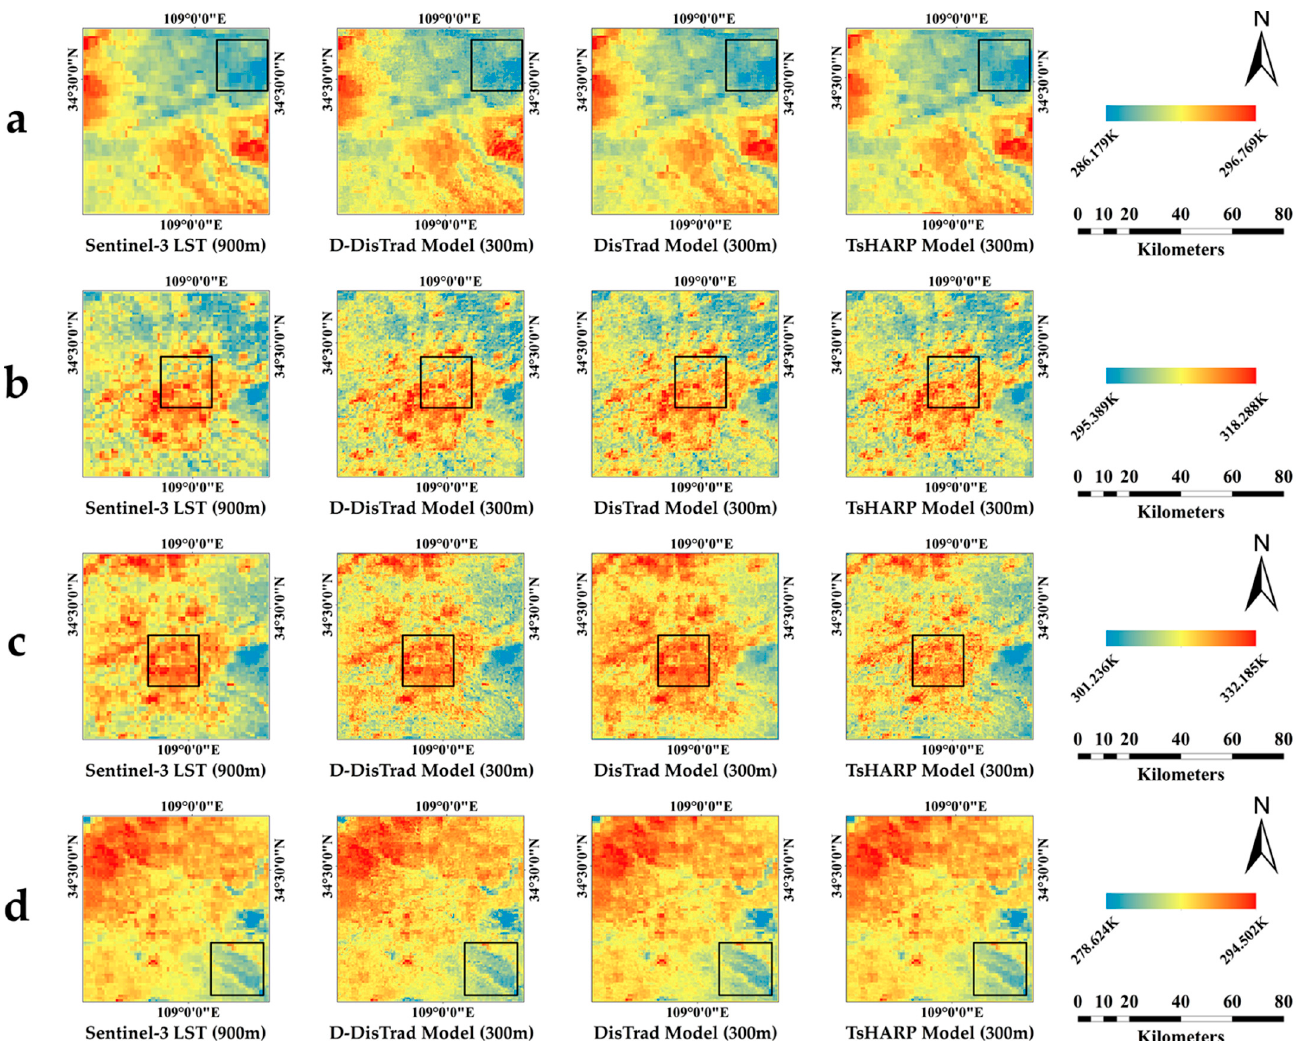
Figure 5. Each line goes from left to right, showing SLSTR LST (900 m), D-DisTrad LST (300 m), DisTrad LST (300 m), and TsHARP LST (300 m) data for site 3 across 4 seasons: ( a ) winter; ( b ) spring; ( c ) summer; ( d ) fall. The black box shows the selected areas of noticeable change.